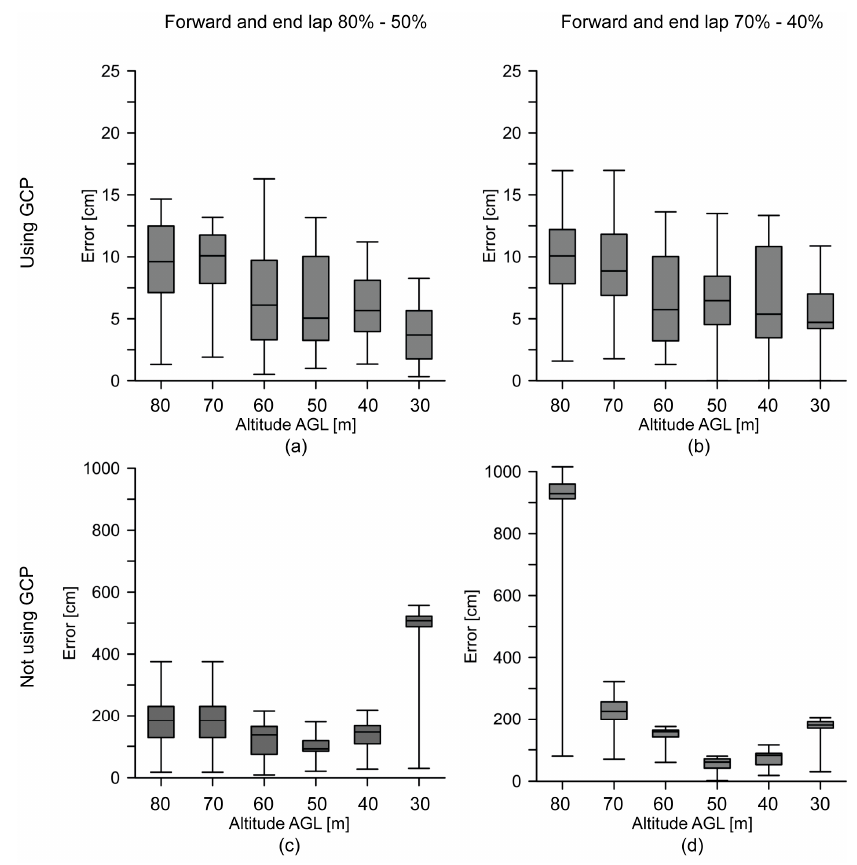
Figure 8. ( a – d ) Root mean square error (RMSE) box plot graph factoring altitude AGL; forward and side lap ( a , c ) 80%–50% ( b , d ) 70%–40% and; processing ( a , b ) with or ( c , d ) without ground control points (GCPs).